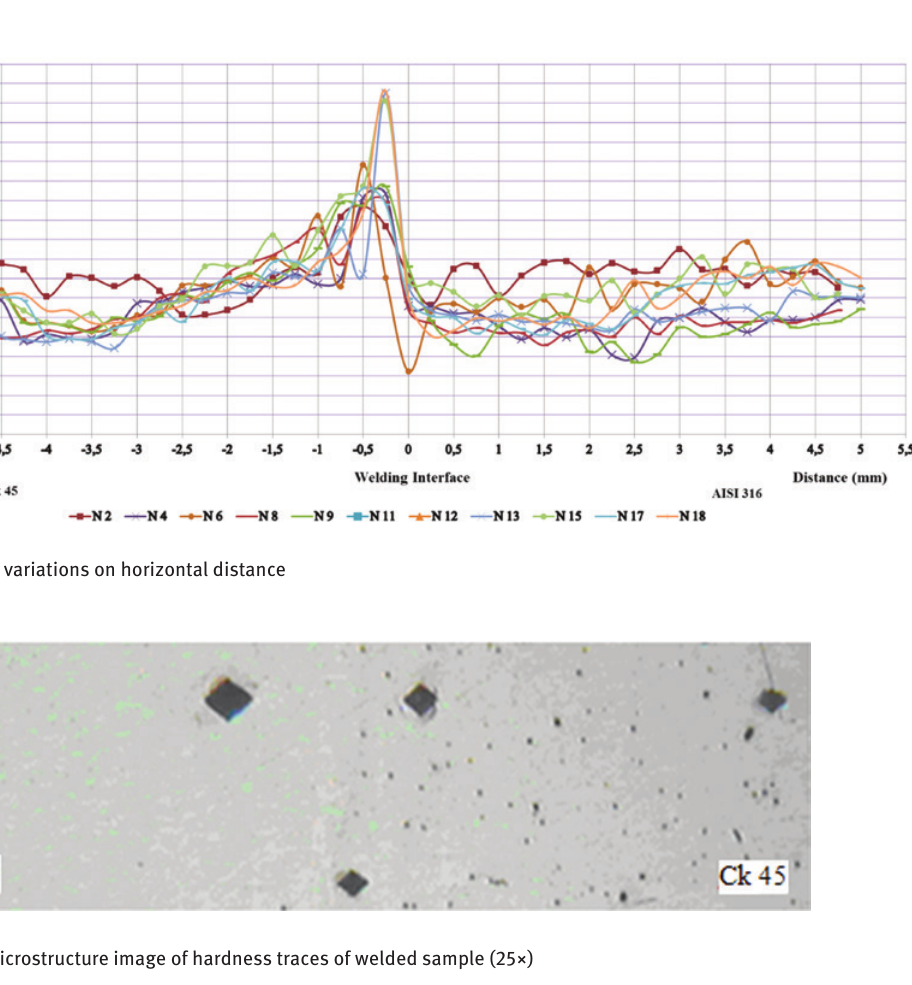
Fig. 13: Optical microstructure image of hardness traces of welded sample